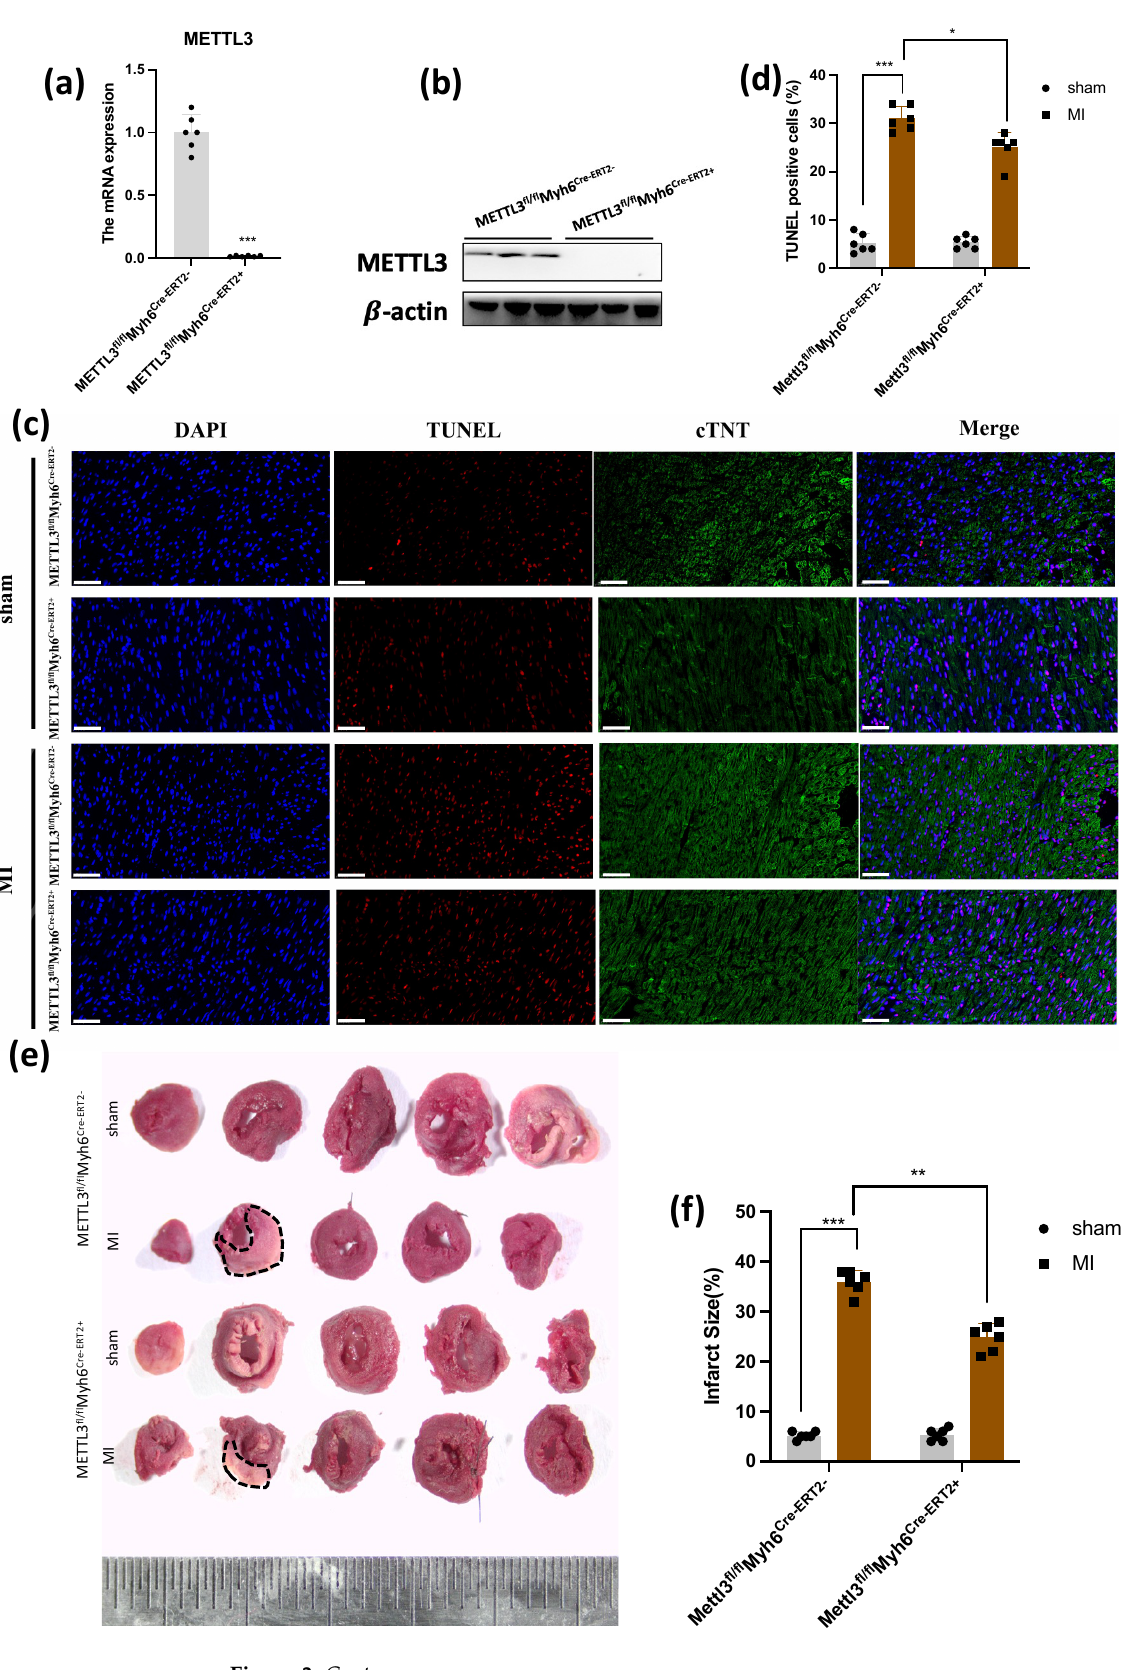
Figure 3. Cont Figure 3. Cont .